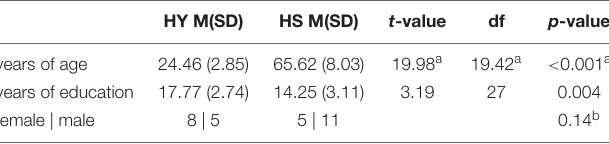
TABLE 1 | Group comparison of demographic